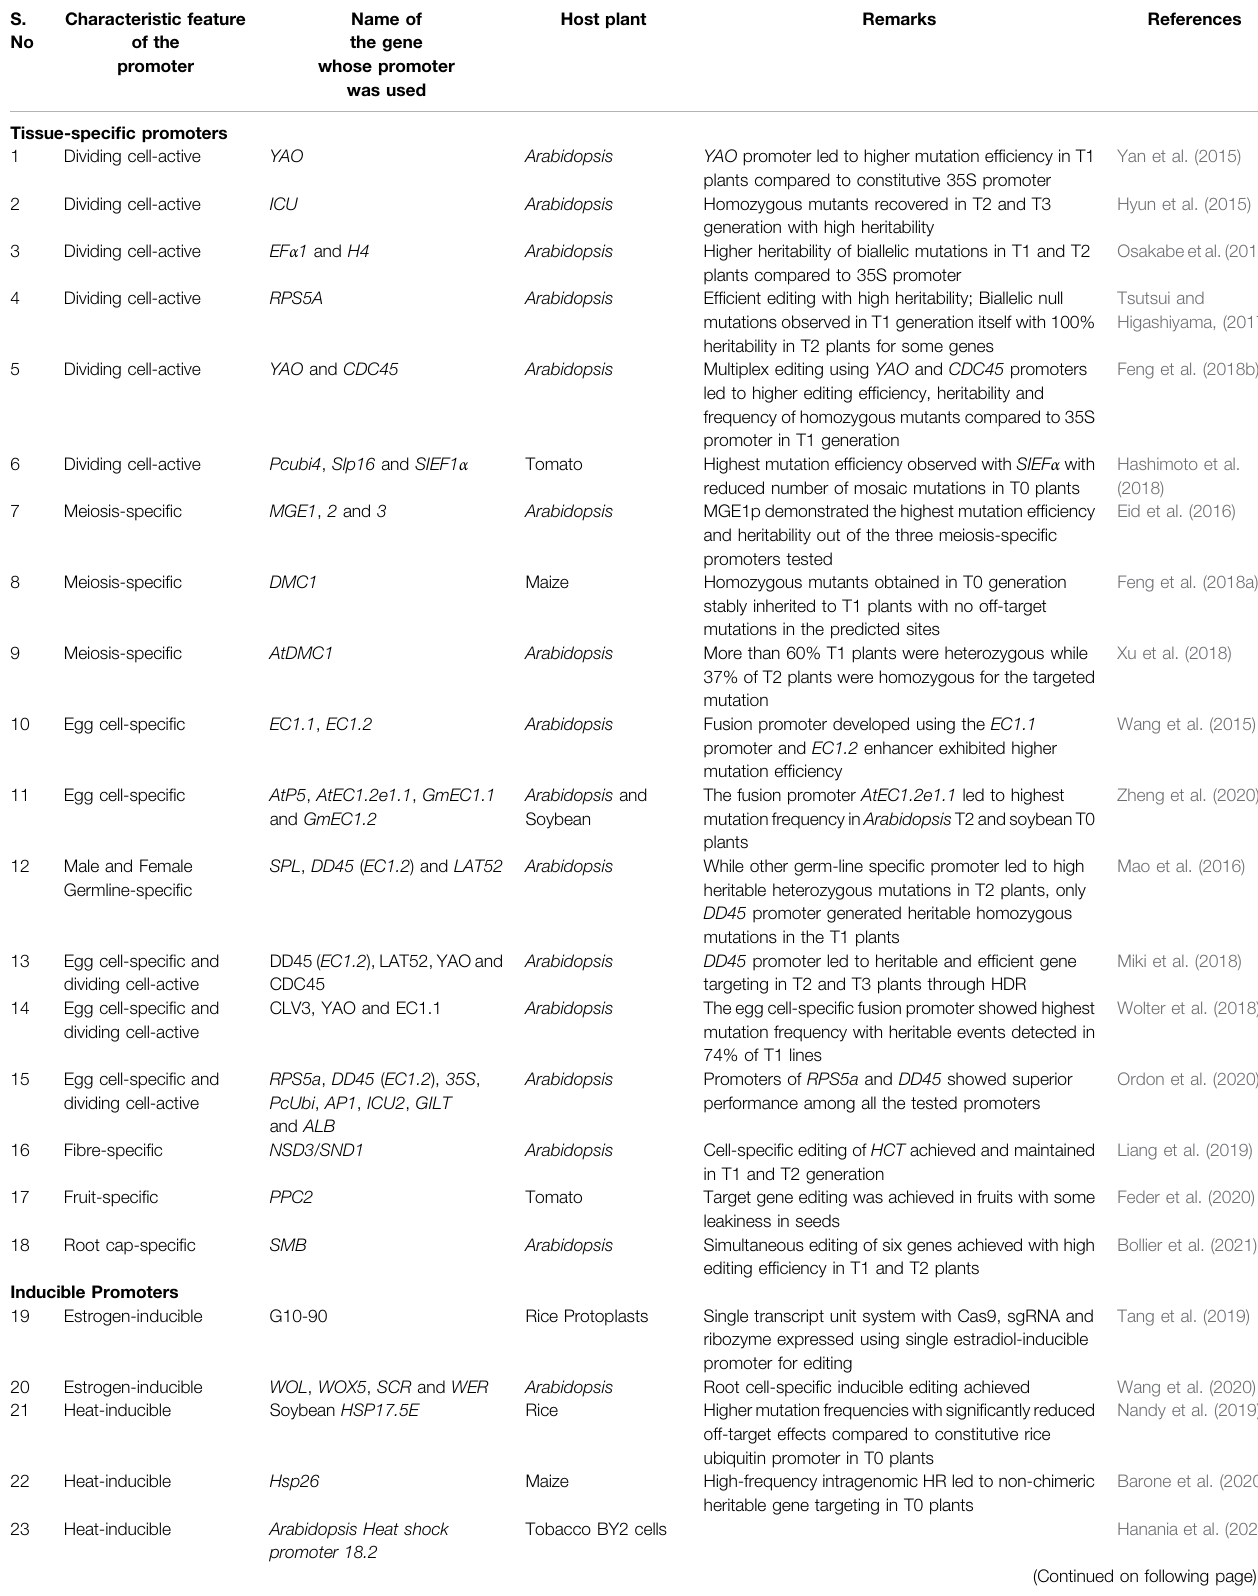
TABLE 1 | List of spatiotemporally regulated promoters used for driving Cas9/gRNA expression in